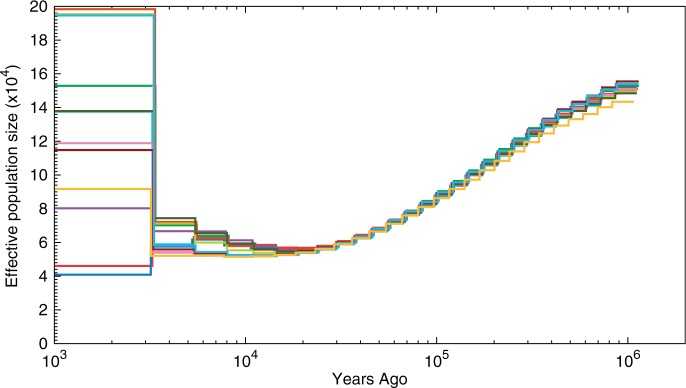
Inferred population history from distribution of IBS (identical by state) tract length distributions Li and Durbin (2011). Curves represent the inferred population history of individual rat samples. Estimates are based on non-CpG prone sites only and using a proximity filter of md = 5 bp. See supplementary figures S10 and S11, Supplementary Material online, for effects of these choices.